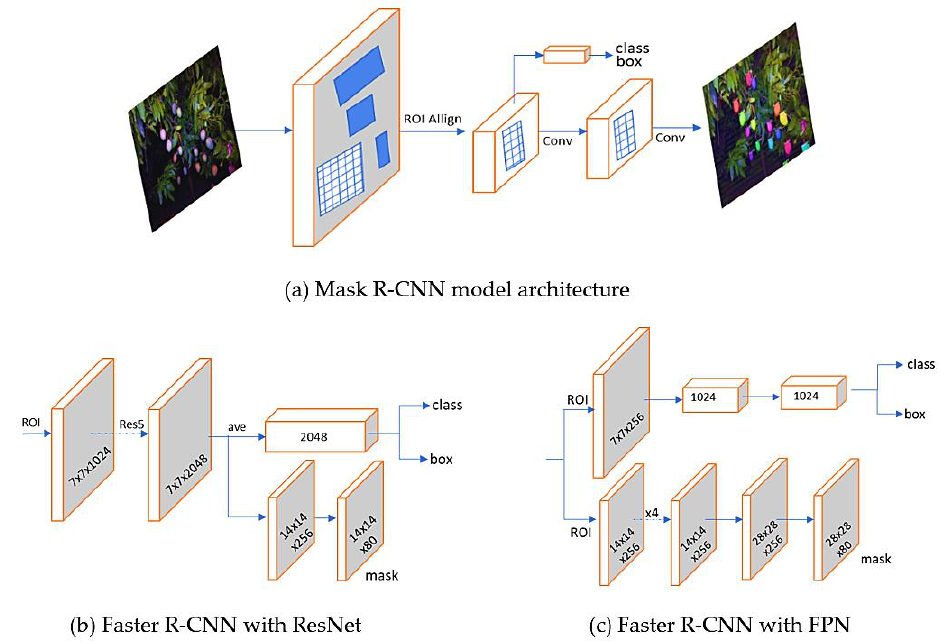
Figure 2. Mask R-CNN head architecture, involving addition of a Mask branch to ResNet [18] and backbone with feature pyramid network (FPN) backbone with feature pyramid network (FPN) [26] .